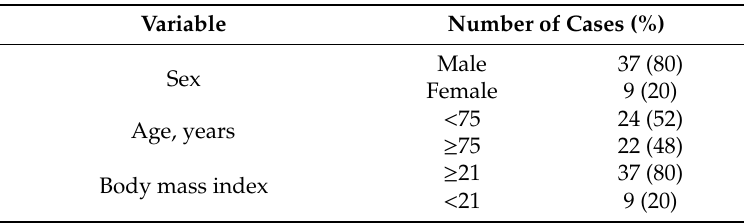
Table 1. Baseline demographic and clinical characteristics ( n =